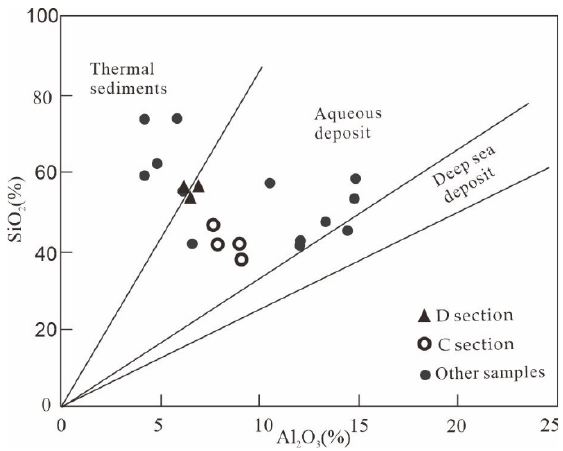
Figure 8. SiO 2 /Al 2 O 3 diagram of CN outcrop [62].